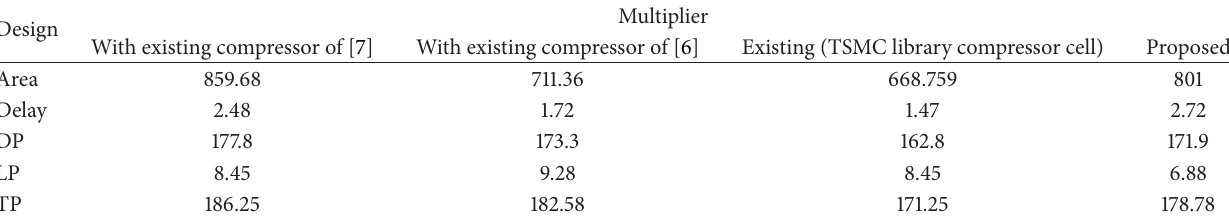
Table 2: Results of multiplier with existing and proposed compressor architecture.